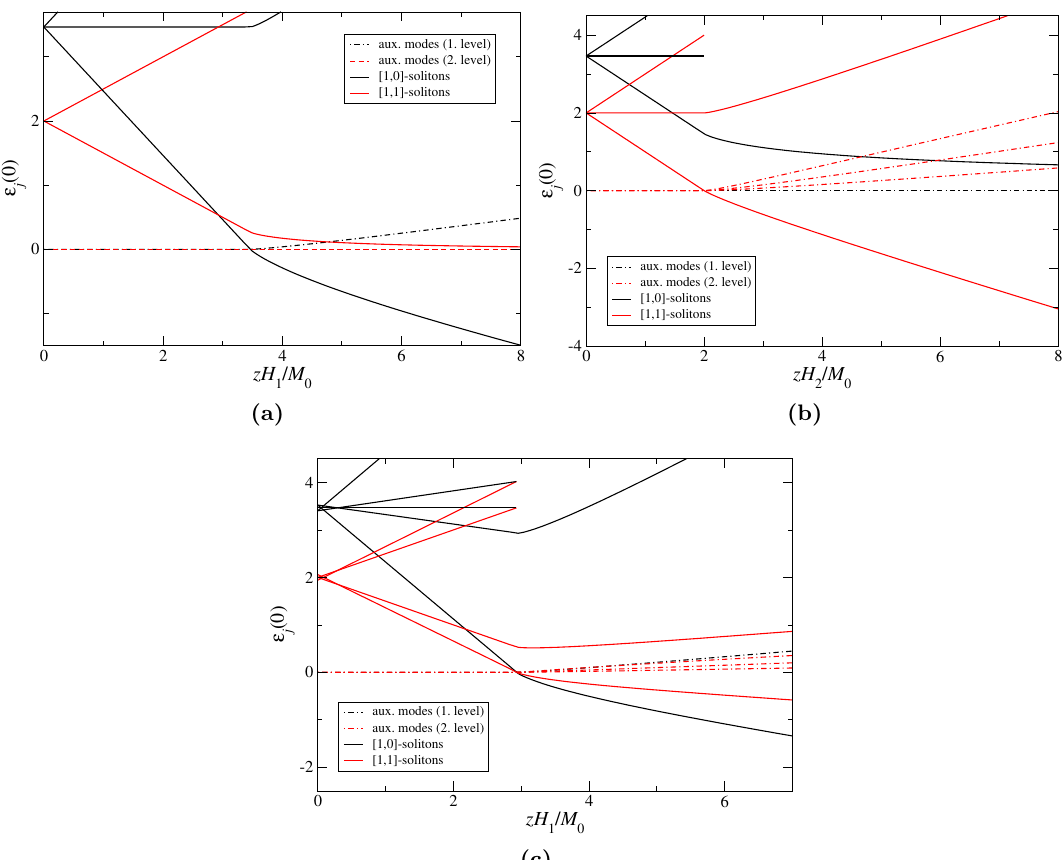
Figure 3 . The zero temperature spectrum of elementary excitations (and Fermi energy of solitons in the condensed phases) (cid:15) ( m )